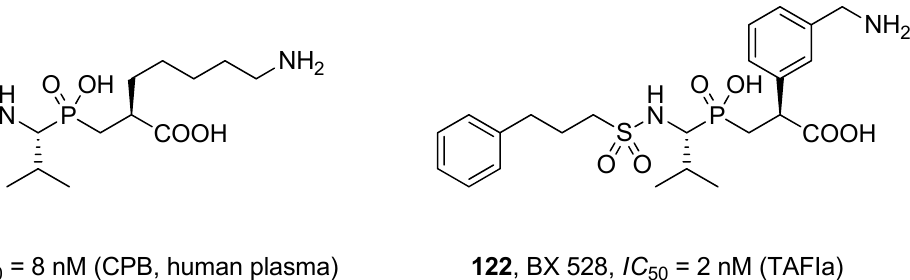
Figure 4. The structure and activity of phosphinic dipeptide inhibitors of TAFIa/carboxypeptidase B. 121 , EF6265, IC